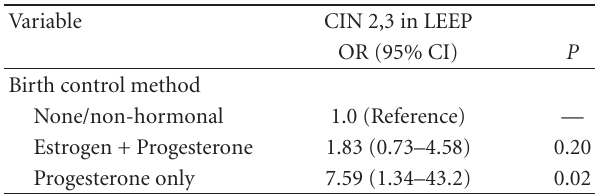
Table 3: Univariate logistic regression with birth control method and CIN 2,3 in LEEP.